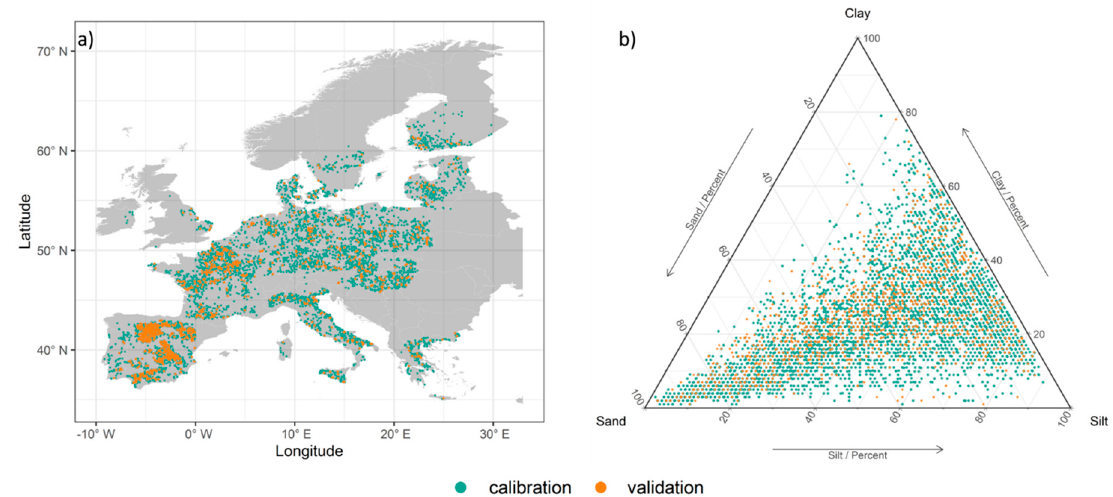
Figure 5. Soil points where LUCAS 2009 samples were taken in previous in situ surveys from cropland areas; ( a ) illustrates the calibration (orange) and the validation samples (cyan), as resulted after the preprocessing ( n = 6136); while ( b ) illustrates how the selected samples are placed within the soil texture triangle .